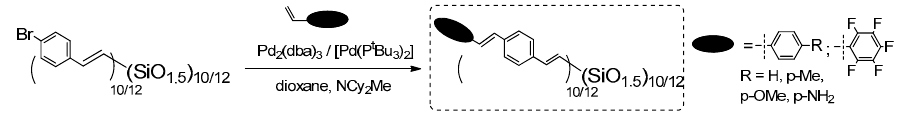
Figure 14. T 10 and T 12 stilbene derivatives obtained by Heck coupling and cross-metathesis.